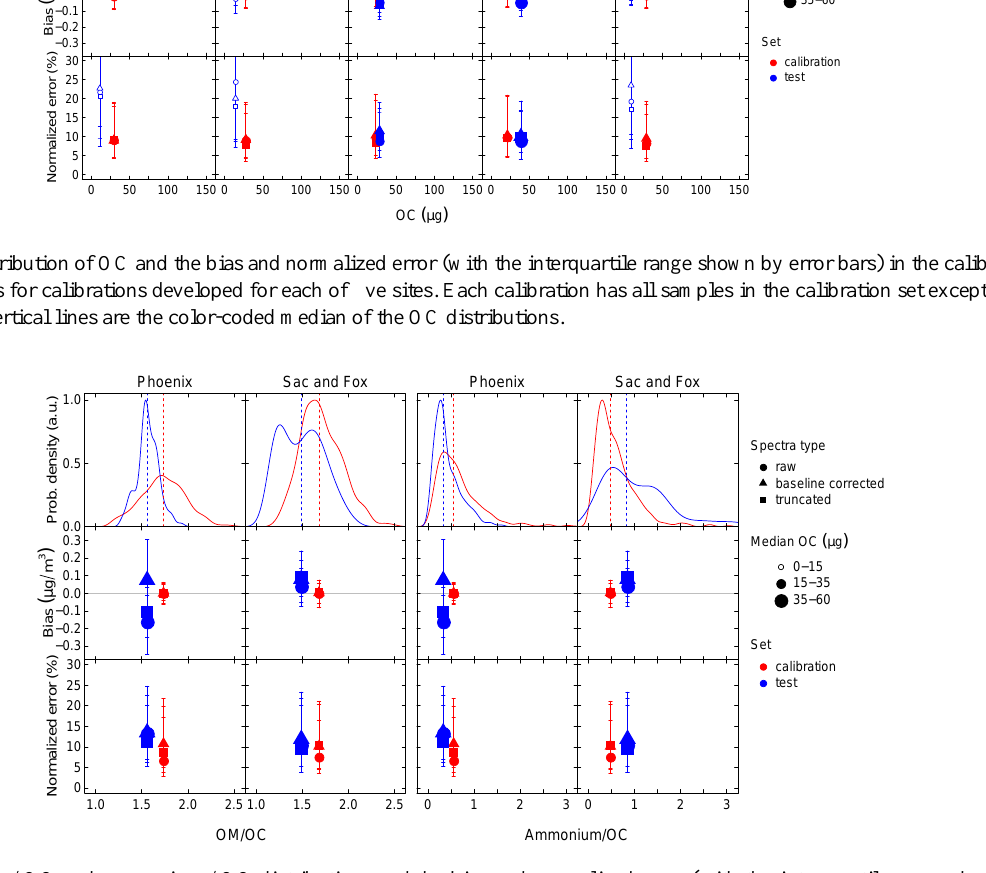
ibration sets for all sites are shown in Sect. S7 of the Supple-